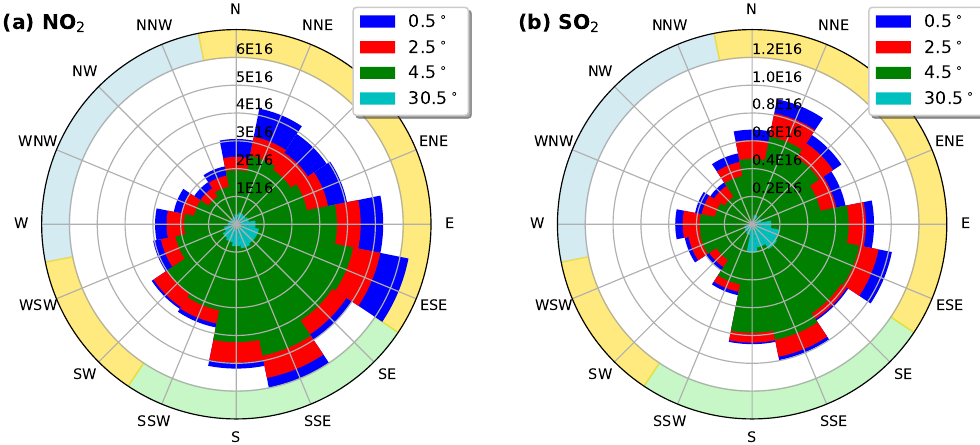
Figure 7. Overlayed wind roses for different elevation angles showing the wind direction distribution of the UV NO 2 (a) and SO 2 (a) differential slant column densities measured in the main viewing direction at 0.5, 2.5, 4.5 and 30.5 ◦ elevation in the years 2013 and 2014. The wind roses are plotted on top of each other, i.e. the highest values were measured at the lowest elevation angle (blue bars). The colored sectors show directions with wind from land (green), open North Sea (blue) and mixed origin (yellow).